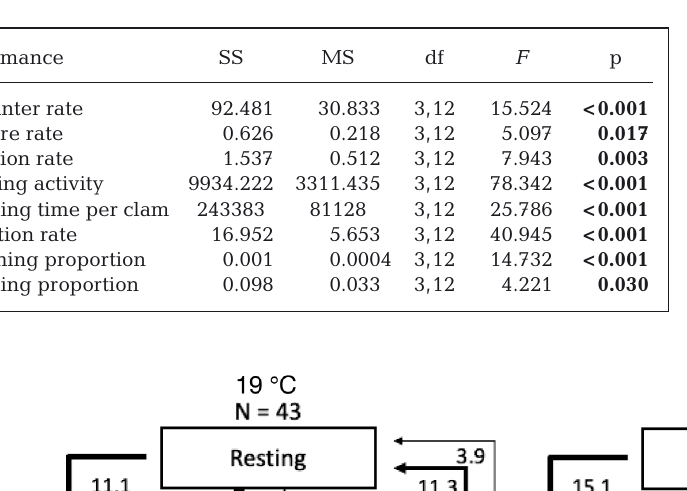
Table 2. ANOVA for the effects of temperature on Rapana venosa foraging behaviors (encounter rate, capture rate, ingestion rate, foraging activity and